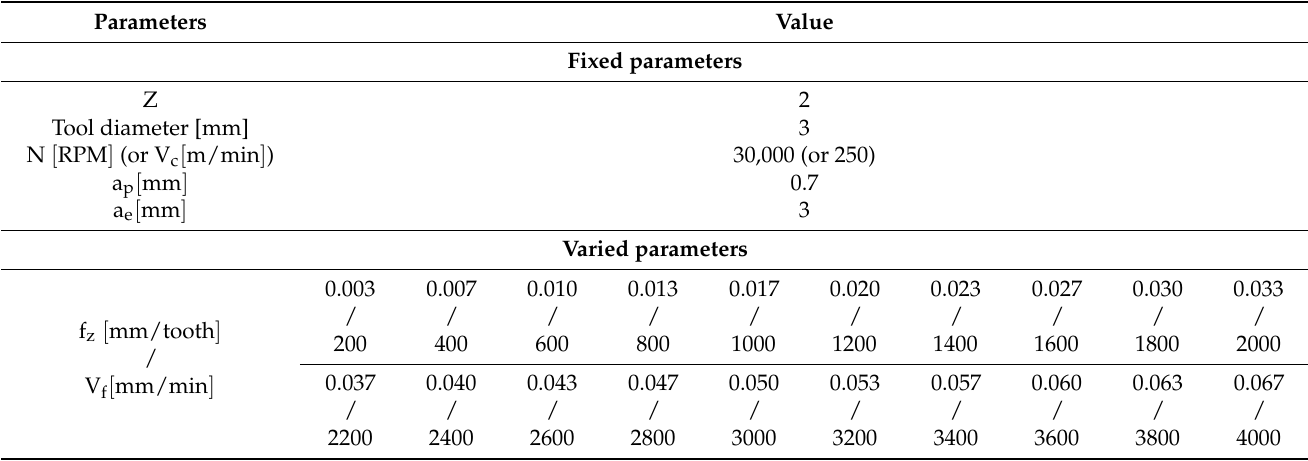
Table 1. Fixed and varied parameters.